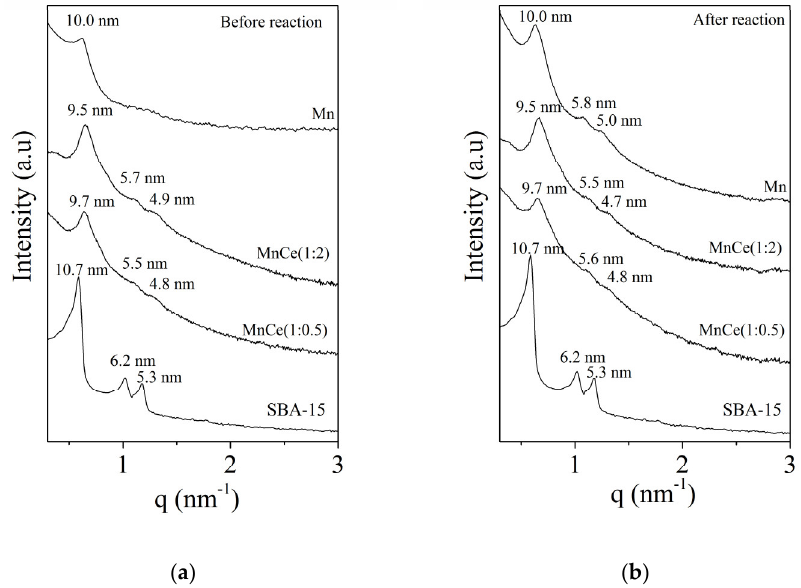
Figure 1. SAXS pattern of the catalysts before ( a ) and after ( b ) the VOC combustion.